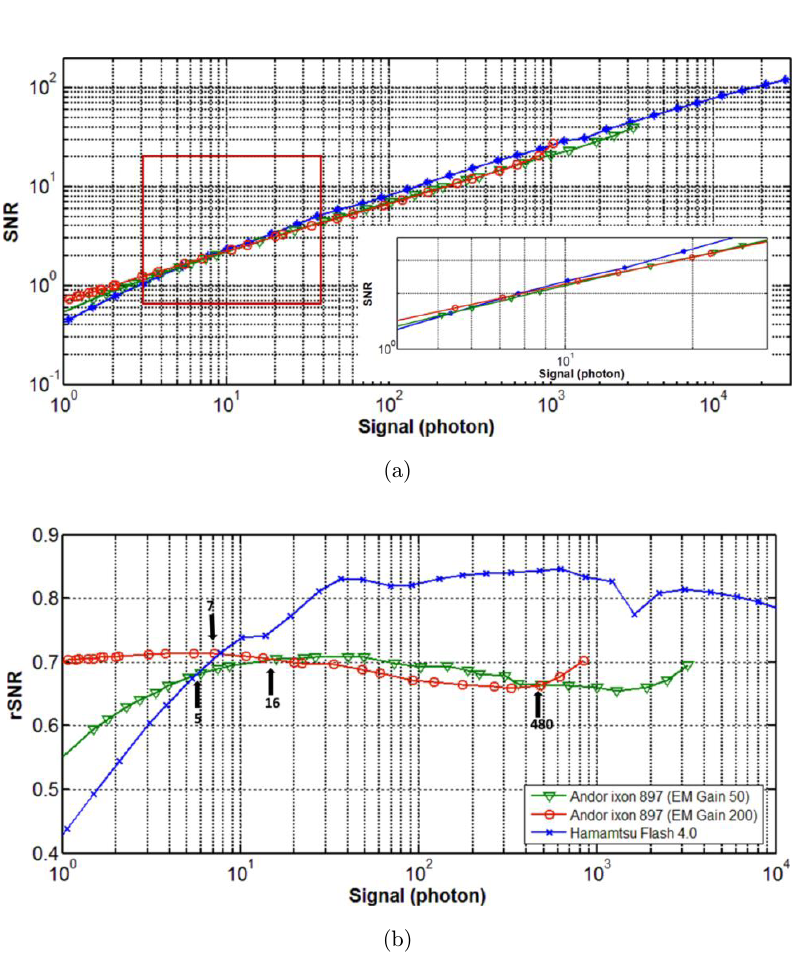
Fig. 7. Comparing the performance of a Hamamatsu Flash 4.0 sCMOS and an Andor iXon 897 EMCCD. (a) SNR curves. An enlarged view of the data inside the red rectangle is given in the right corner. (b) rSNR curves. The measurement is performed under 593 nm, where the QE is 0.72 for the sCMOS camera and 0.96 for the EMCCD camera,